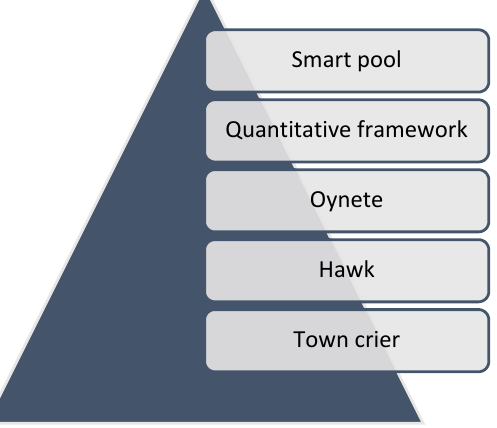
Figure 7. Security can be enhanced by improving tools.